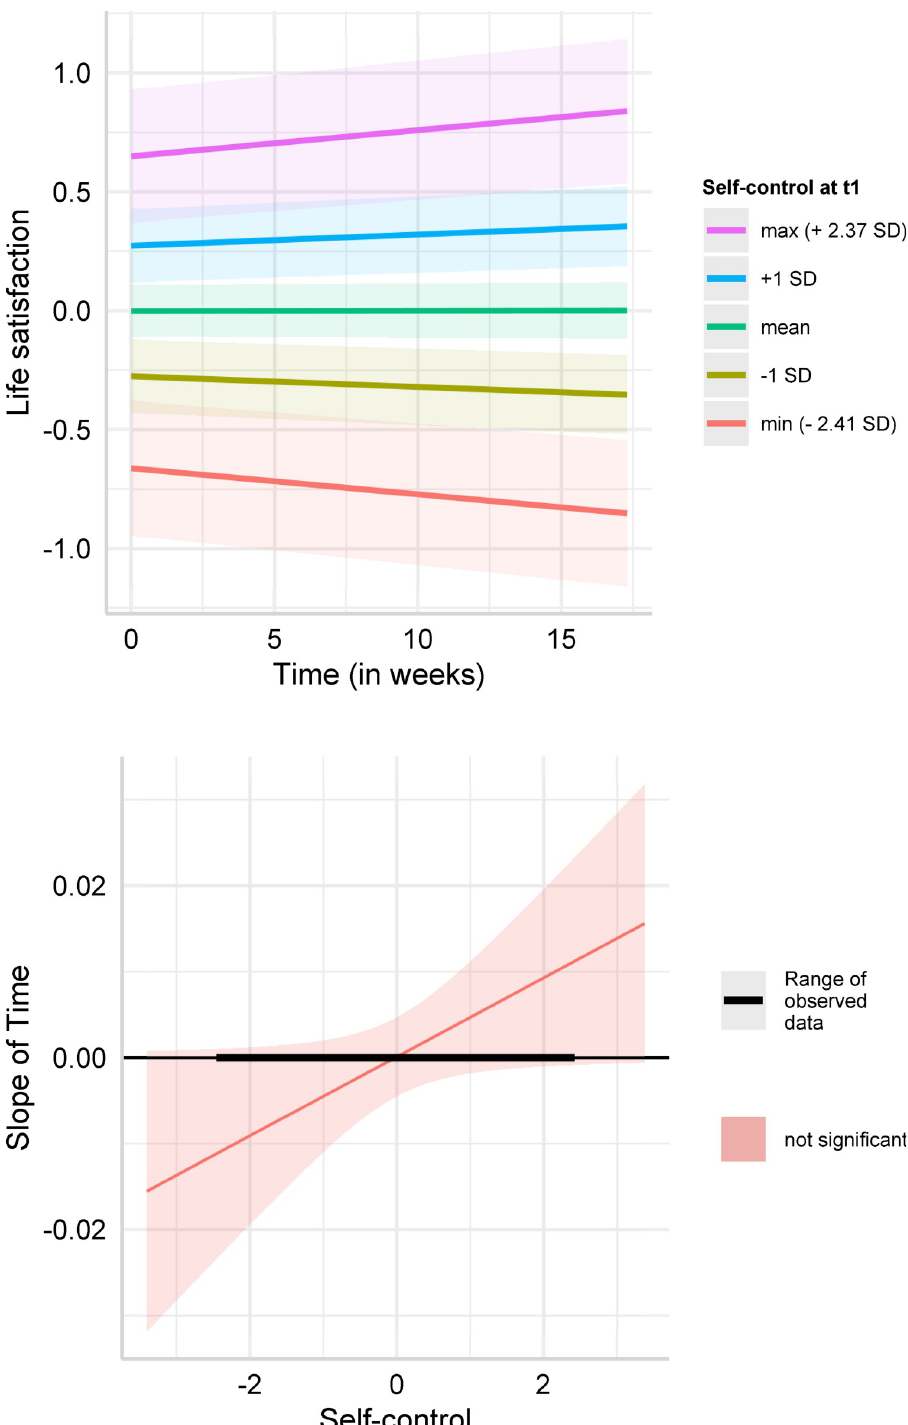
Fig 4. A. Predicted values of life satisfaction. Simple slope estimates for Model 1 (dependent variable: life satisfaction) in Table 4. The figure depicts predicted values of life satisfaction (standardized around 0) over time for low self-control (-1 SD below mean), average self-control, high self-control (+1 SD above mean) individuals, minimum self-control in the sample (-2.41 SD), and maximum self-control in the sample (2.37 SD). B. Johnson-Neyman intervals for life satisfaction. Johnson-Neyman intervals for the simple slope estimates for Model 1 (dependent variable: life satisfaction) in Table 4. The figure depicts the estimated slope of time for each level of trait self-control (standardized around 0) and highlights for which values of trait self-control the simple slope estimate is